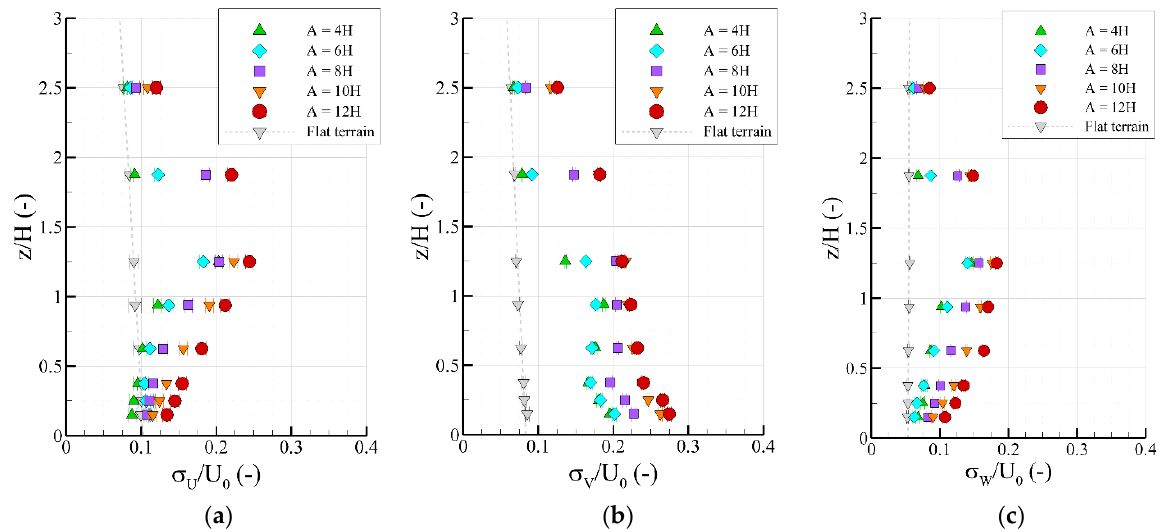
Figure 5. Vertical profiles of the normalized longitudinal velocity fluctuations above the valley midpoints ( a ), lateral velocity fluctuations above the windward slopes of the second ridges ( b ), and vertical velocity fluctuations above the valley midpoints ( c ).